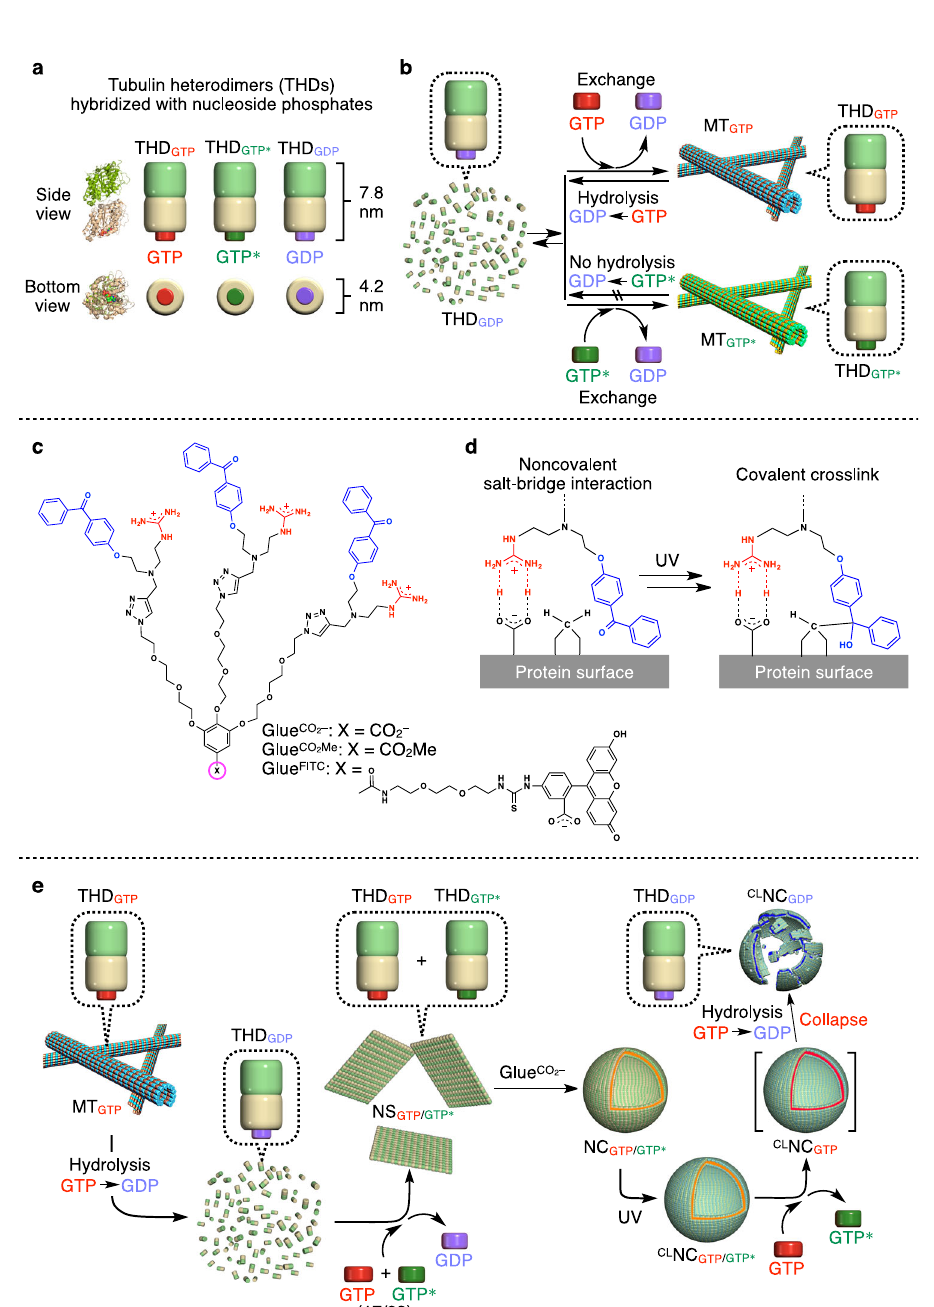
Fig. 1 | Strategy used to prepare THD-based GTP-responsive CL NC GTP/GTP* . a Schematic illustrations of tubulin heterodimers (THDs) hybridized with GTP